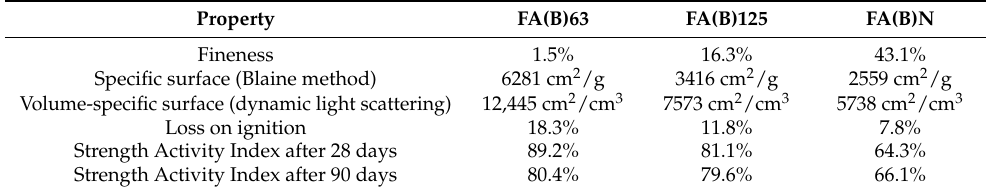
Table 5. Physical properties of sieved fly ash (FA(B)63 and FA(B)125) compared with untreated fly ash (FA(B)N).